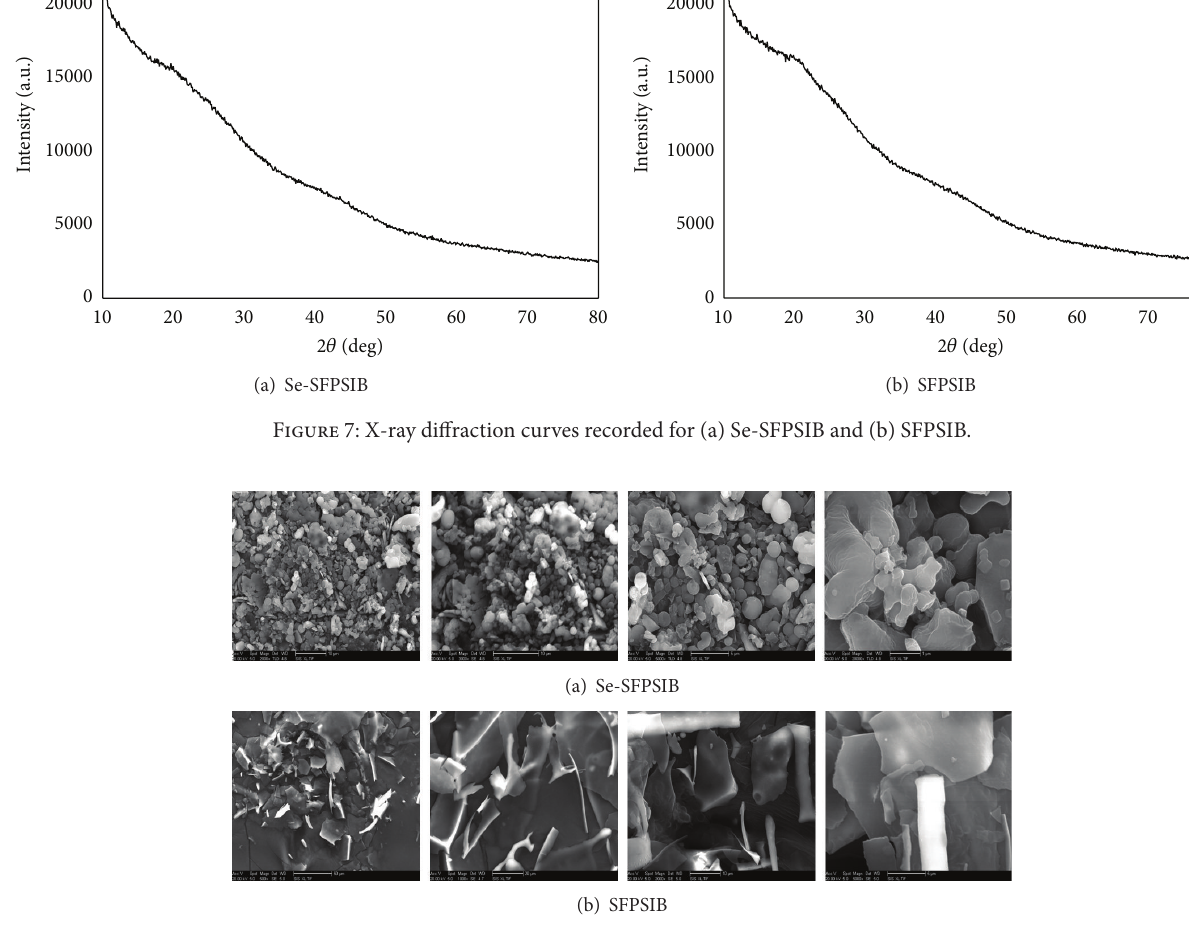
Figure 8: Scanning electron micrographs of Se-SFPSIB and